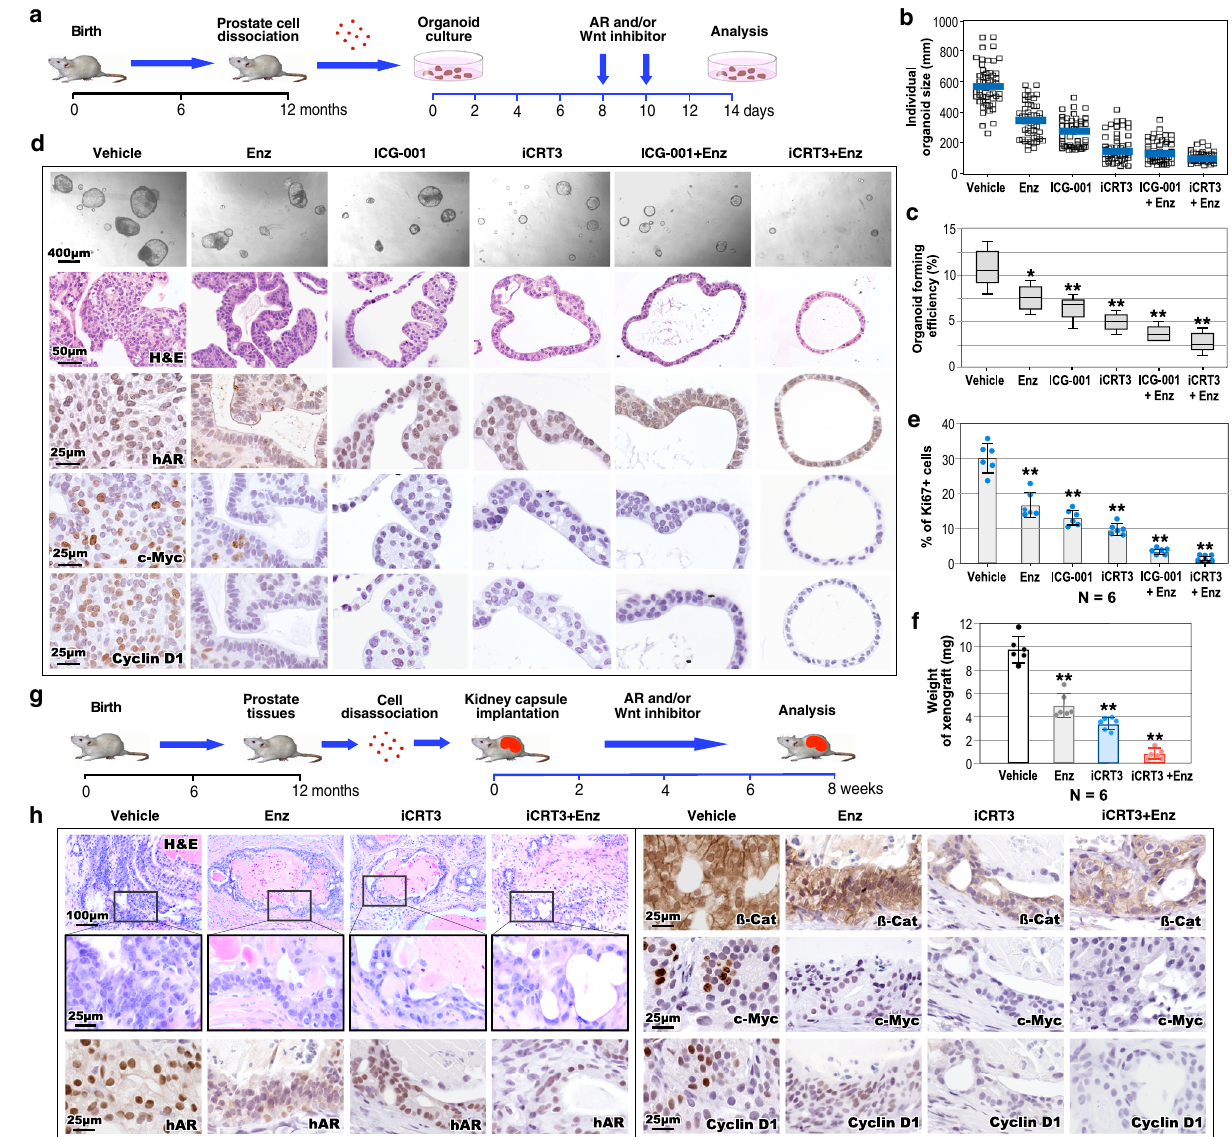
Fig. 8 | Co-inhibition of androgen and Wnt/ β -catenin signaling pathways in prostate tumor growth. a Schematic representation of the experimental design for the ex vivo organoid culture performed. Organoids derived from PCa cells of R26 mTmG/hAR : Osr1 Cre/+ mice were treated with vehicle, antiandrogen (10 µ M Enzaluta- mide; Enz), Wnt inhibitor (10 µ M ICG-001 or 10 µ M iCRT3), or combination of Enz and ICG-001 or iCRT3 two times for 6 days. See also Methods section. b Quanti fi cation of individual organoid size. Organoids per treatment group ( n =50) examined over three independent experiments. The center blue bar indi- cates the median value in each group. c Quanti fi cation of organoid forming ef fi - ciency showing the percentage of organoids above 50 μ m diameter per total cells seeded at day 0 in a well. The center line represents the median value; the box borders represent the lower and upper quartiles (25% and 75% percentiles, respectively);theendsofthebottomandtopwhiskersrepresenttheminimumand maximumvalues,respectively. d Representativeimagesofbright fi eld,H&EandIHC